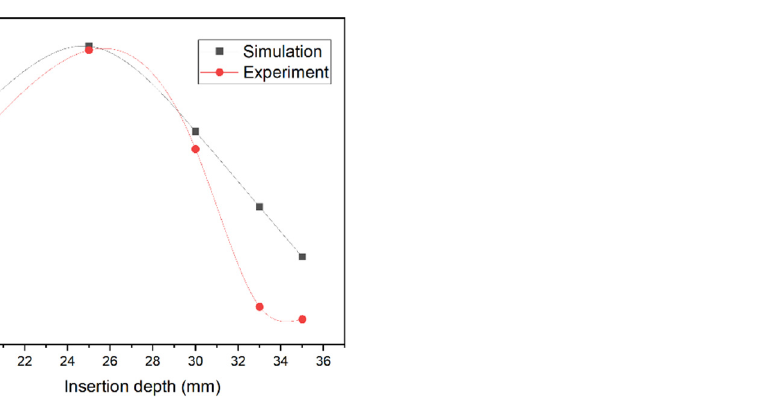
Figure 12. Separation efficiency of mini-hydrocycloness with different vortex finder depth.